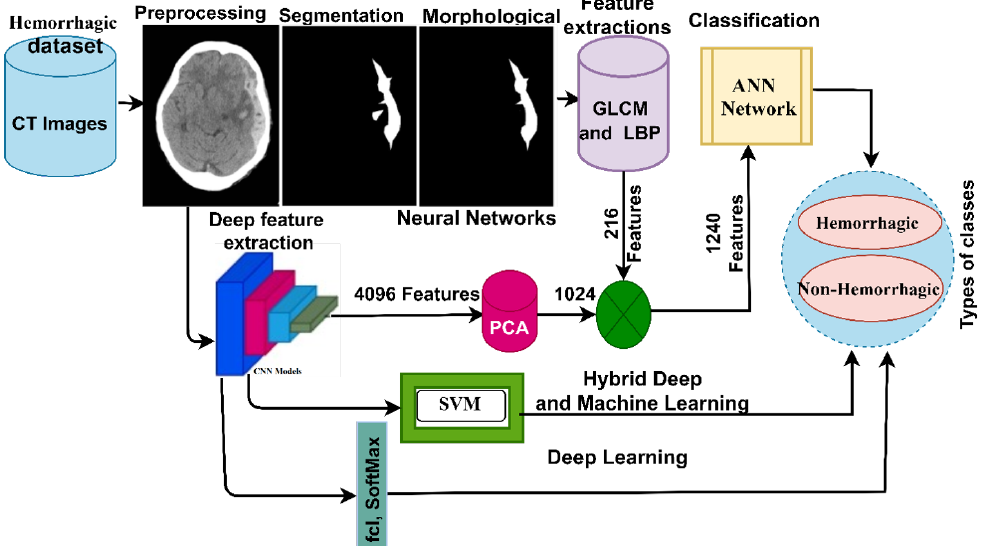
Figure 1. Proposed methodology for diagnosing CT images for early detection of hemorrhage